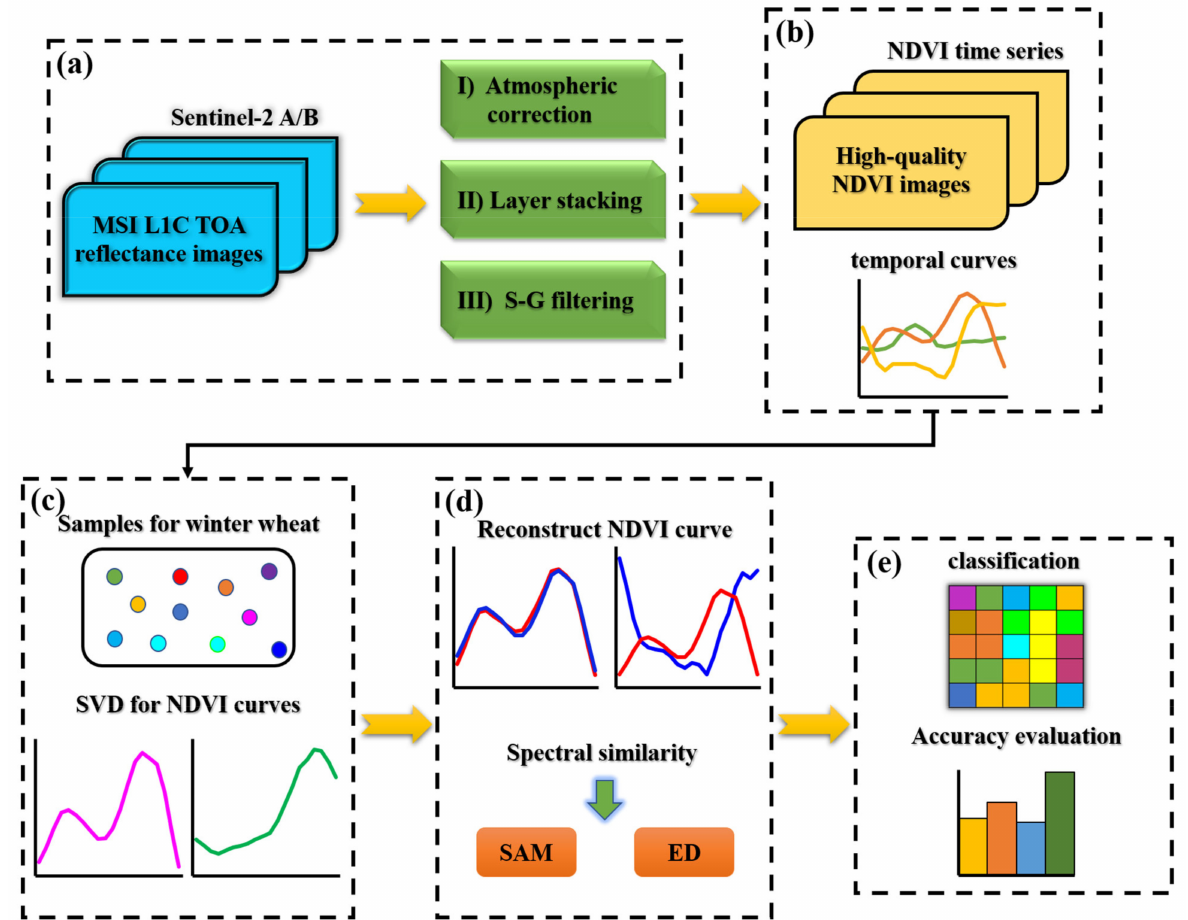
Figure 3. The workflow of the spectral reconstruction method based on singular value decomposition